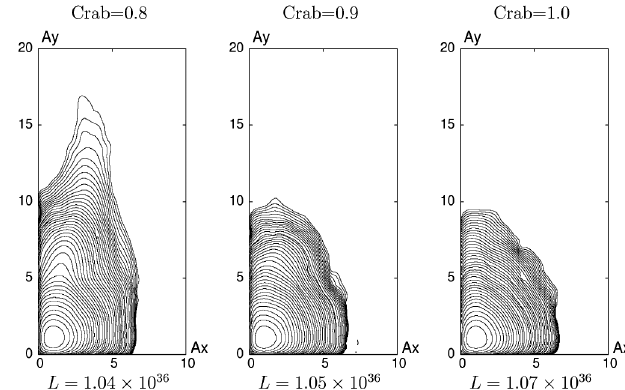
FIG. 9. Contour plots of the equilibrium beam density distri- bution for SuperB LER and luminosity (numbers at the bottom, in cm (cid:4) 2 c (cid:4) 1 ) versus the crab